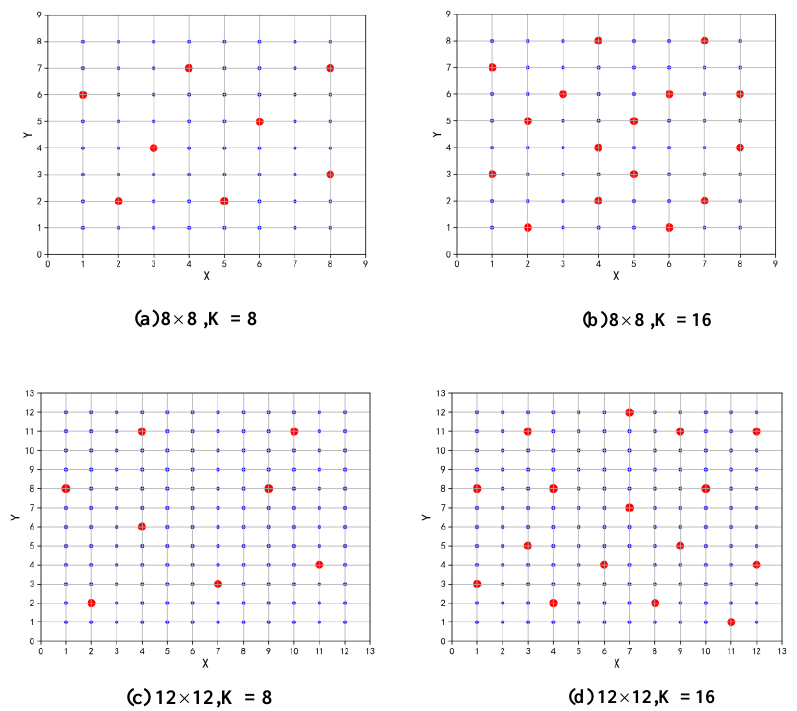
Figure 17. Roadside Units Deployment (RSUD) schemes obtained by Center-Rule-Based Neighborhood Search Algorithm (CNSA): ( a ) 8 × 8 intersections, 8 RSUs; ( b ) 8 × 8 intersections, 16 RSUs; ( c ) 12 × 12 intersections, 8 RSUs; ( d ) 12 × 12 intersections, 16 RSUs.